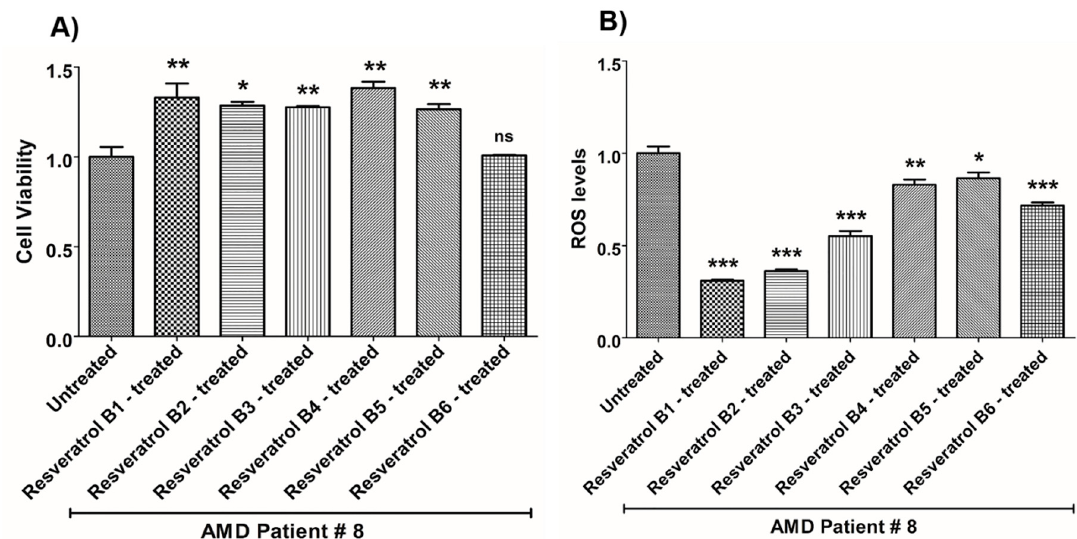
Figure 9. E ff ects of resveratrol formulations on cell viability ( A ) and ROS levels ( B ) in AMD patient #8.